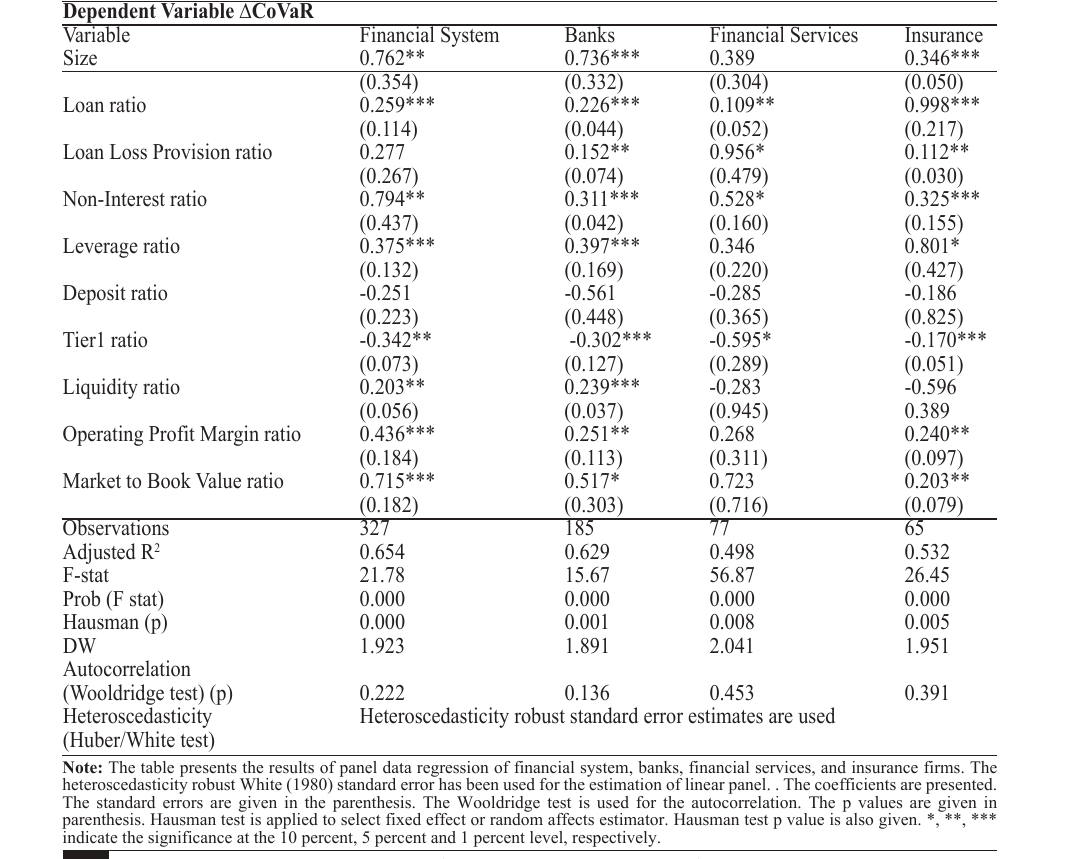
Results of Regressions for Financial Institutions of